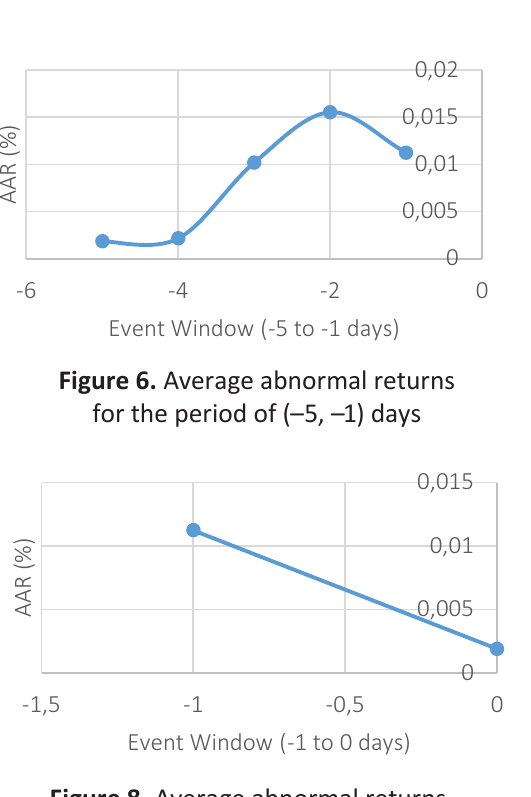
Figure 9. Average abnormal returns for the period of (–1,+1) days